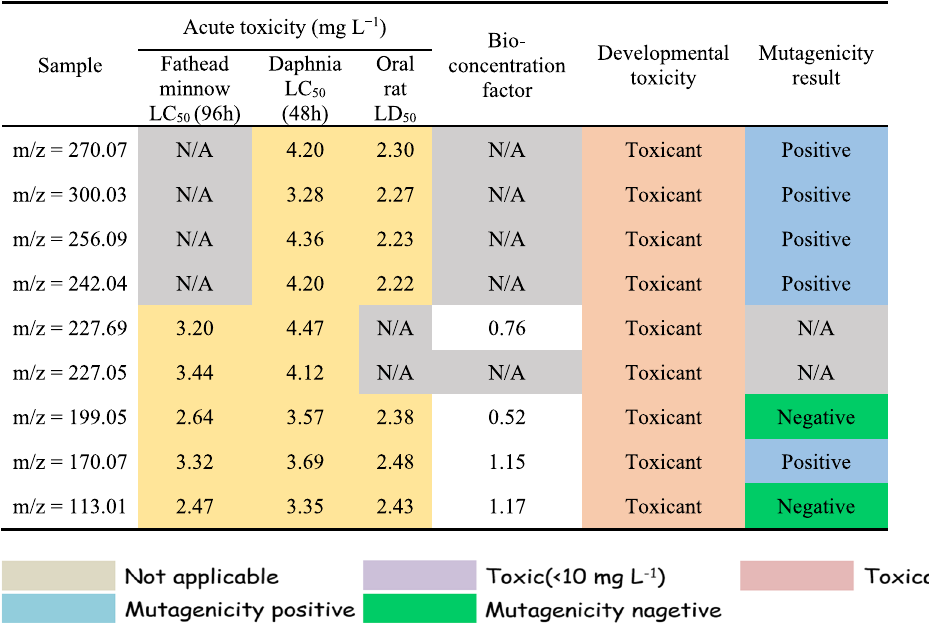
Table 2 Toxicological of NTP and its intermediates predicted by